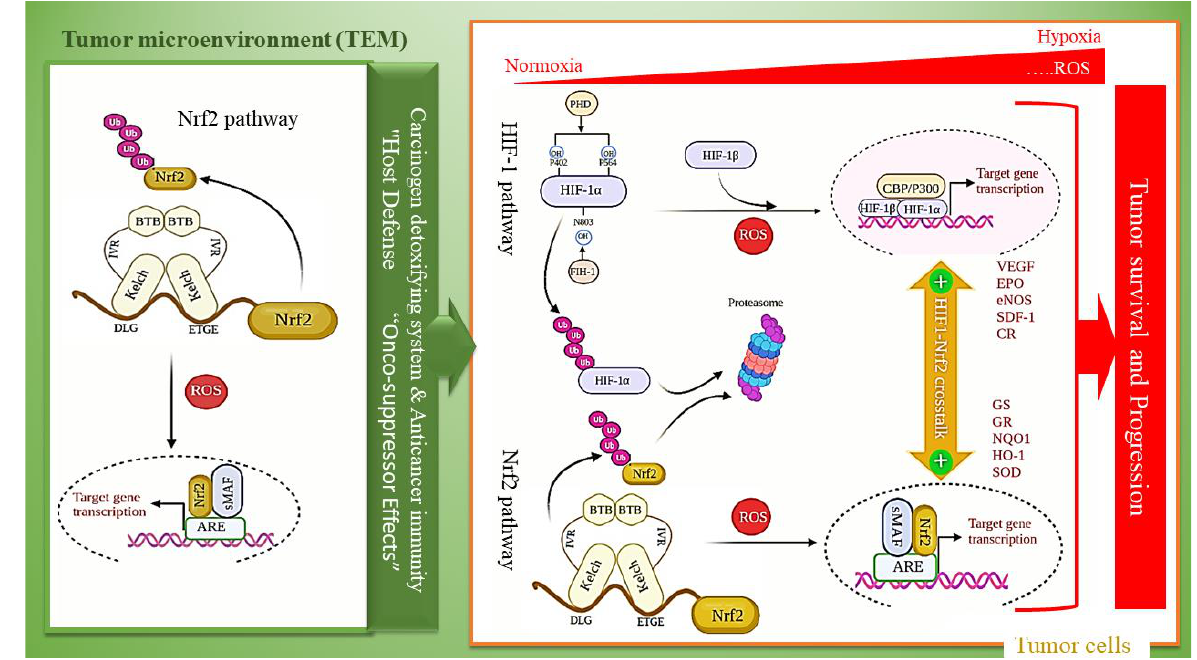
Figure 4. Dual-edge sward functioning of Nrf2 with tumor cells and crosstalk between Nrf2 and HIF-1 activation. Under hypoxia and in the presence of oxidative stress, Nrf2 and HIF1 both enhance the tumor malignancy in tumor cells, but Nrf2 activation in the tumor microenvironment (TME) triggers anticancer immunity, thus suppressing tumors.